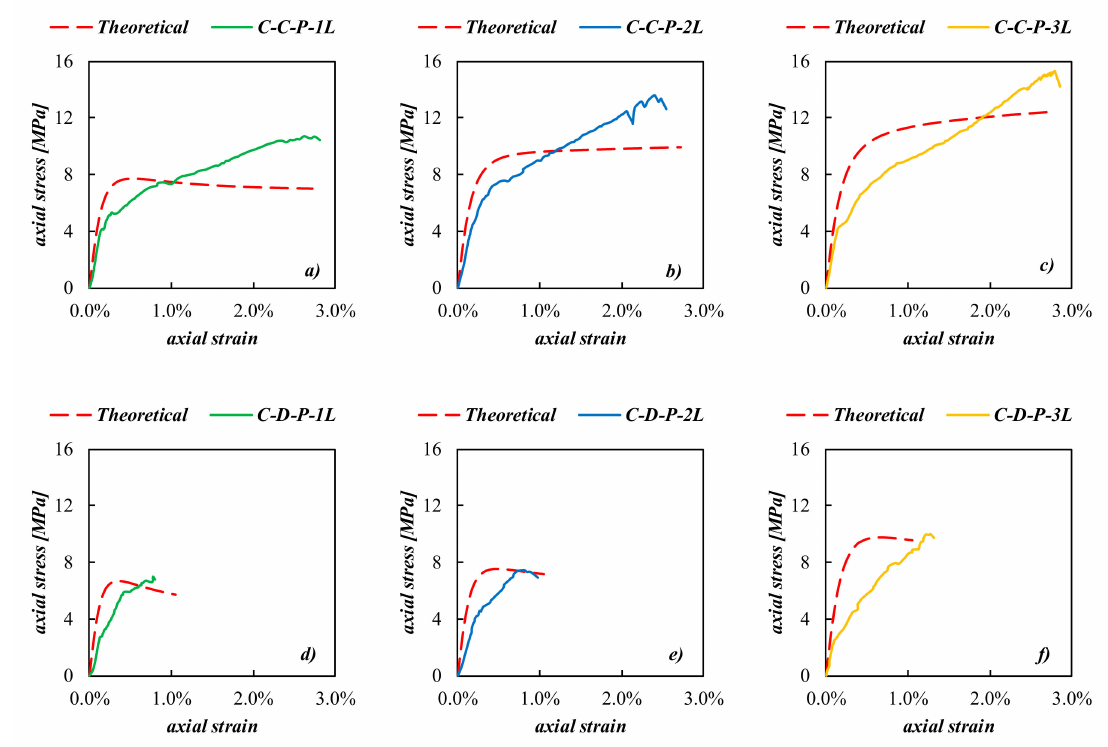
Figure 10. Experimental versus theoretical comparison of the axial stress–strain laws: ( a ) C-C-P-1L, ( b ) C-C-P-2L, ( c ) C-C-P-3L ( d ) C-D-P-1L, ( e ) C-D-P-2L, and ( f )